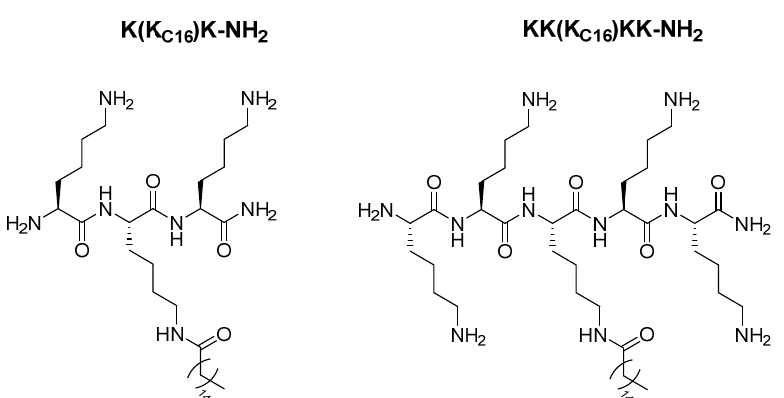
Figure 1. Structures of K(K C16 )K-NH 2 and KK(K C16 )KK-NH 2 shown as models of studied lipotri- and lipopentapeptides.